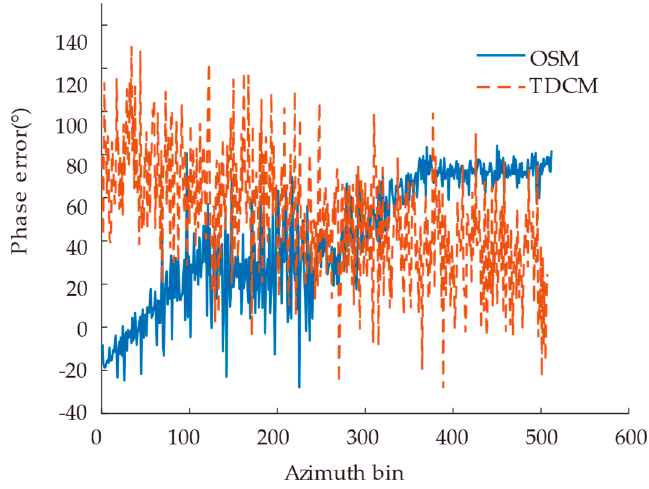
Figure 7. Phase error estimation results using the OSM and TDCM. By averaging the sampling points without estimating the motion error and with deviations from the true channel error, the OSM and the traditional TDCM obtained channel error estimates of 42.6° and 50.7°, respectively. The radial acceleration of the platform is not estimated by the TDCM or OSM. There are still large residual signal errors that remain after only compensating for the channel error estimated by the TDCM or OSM.